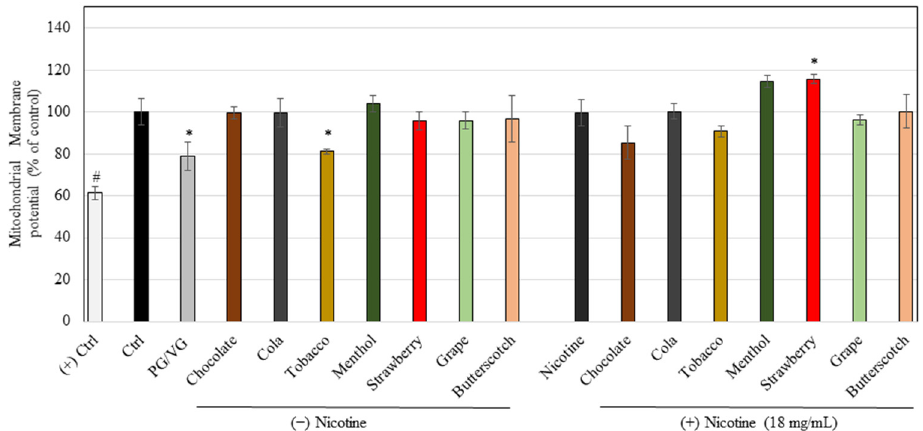
Figure 3. Measurement of mitochondria membrane potential in ARPE-19 cells treated with different e- liquids at a nontoxic concentration of 0.5% for a duration of 48 h. (+) Ctrl refers to the positive control in which the membrane potential has been wiped out in the presence of CCCP. Data are mean ± SD, ( n = 3 per group), One-way ANOVA with Tukey’s post hoc test. * p < 0.05 and # p < 0.0001 vs. Ctrl.